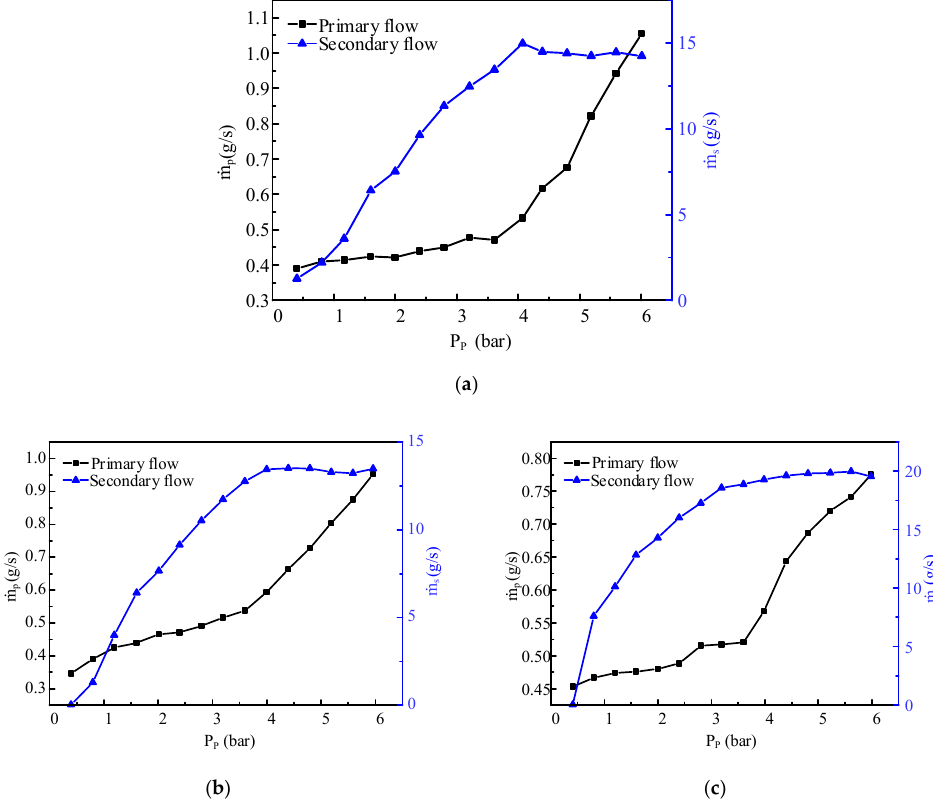
Figure 8. Effects of primary flow pressure on mass flow rates at different NXPs. ( a ) NXP = 0; ( b ) NXP = − 1; ( c ) NXP = +1. − 1; ( c ) NXP = +